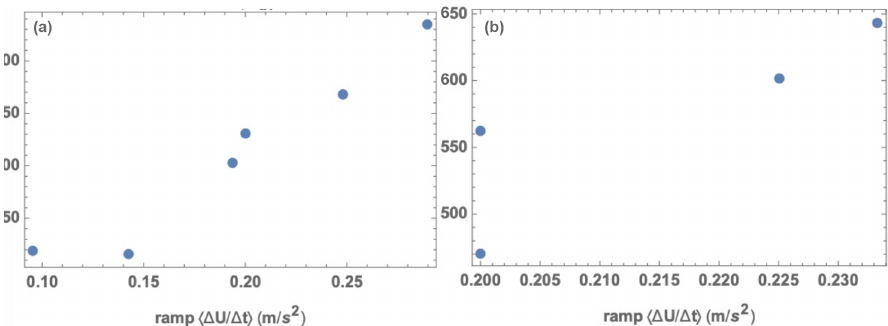
Figure 22. Flap-wise blade-root bending moment M brfw (maximum of three blades) versus ramp bulk acceleration, for cases with ramp- induced U > V rated : turbine 3 (a) and turbine 8 (b) , from LES/Flex. Vertical-axis values obscured for proprietary reasons.